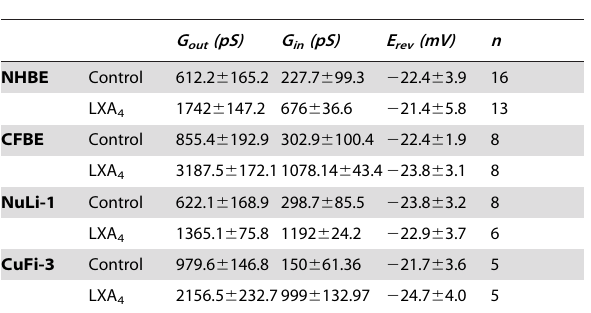
doi:10.1371/journal.pone.0037746.t001